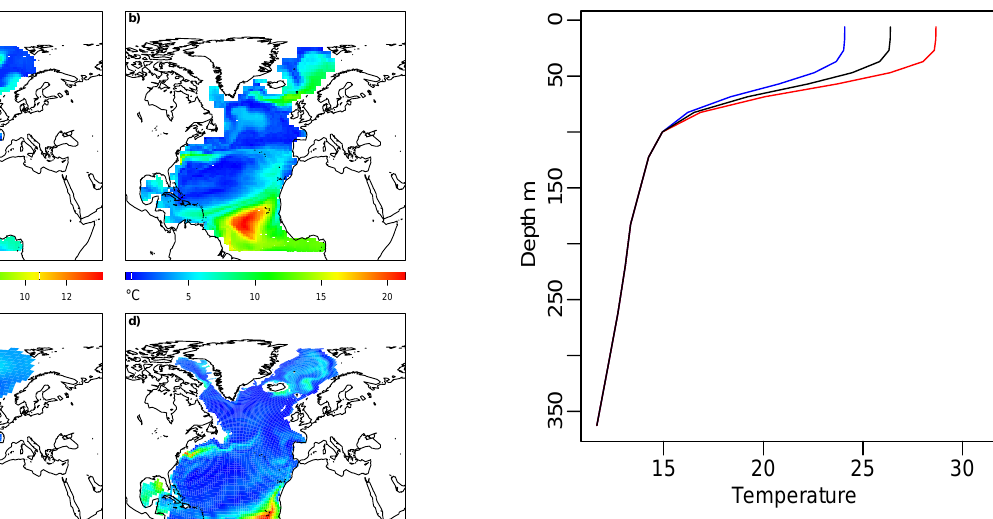
Fig. 7. Schematic plot showing a modern temperature profile (black) and two possible past temperature profiles that are the same at depth, but have either stronger (red) or weaker (blue) stratifica- tion. If planktonic foraminifera responded to temperature at 100m, a transfer function calibrated against 10m will reconstruct the same SST in all three cases. The reconstruction for the case with the weaker stratification will be biased towards warm temperatures; conversely, the case with stronger stratification will have a cold bias to the